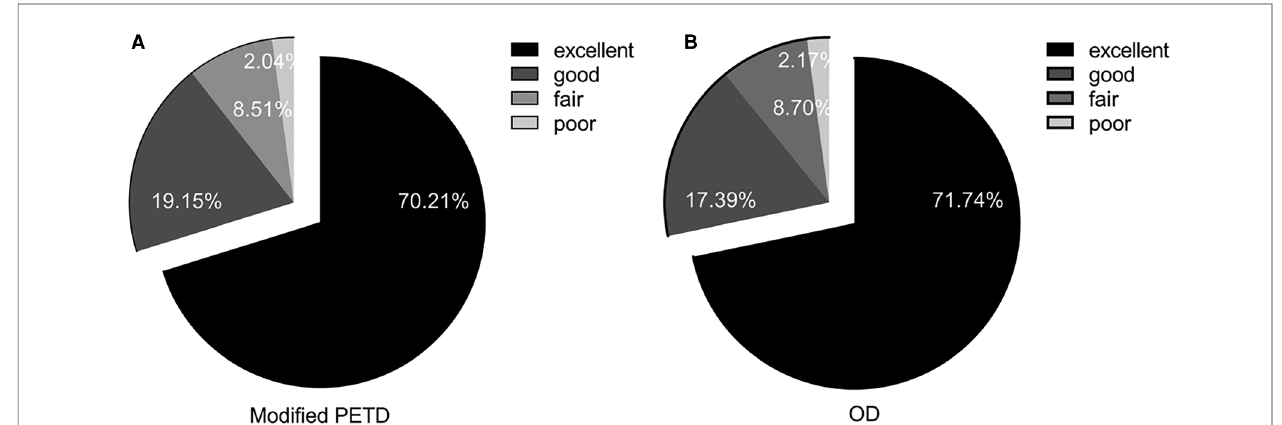
FIGURE 7 | Modi fi ed MacNab scores for the modi fi ed PETD group ( A ) and for the OD group ( B ) at the postoperative follow-up at 12 months.